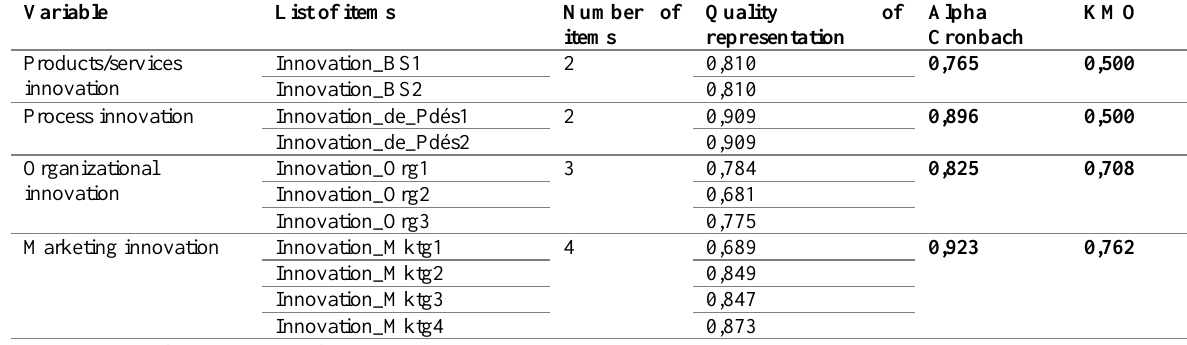
Table 4: Results purification of the measurement scale of the four innovation practices variables